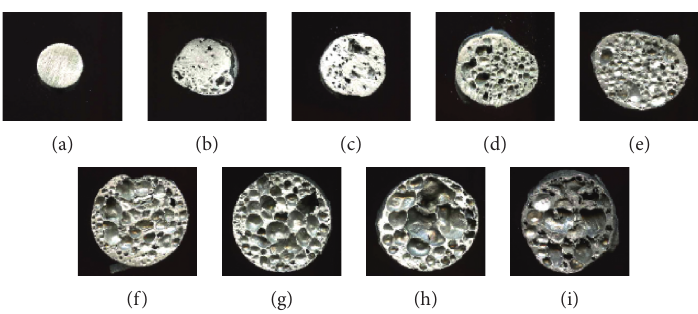
Figure 5: Expansion and foaming process of aluminum foam and its pore structure